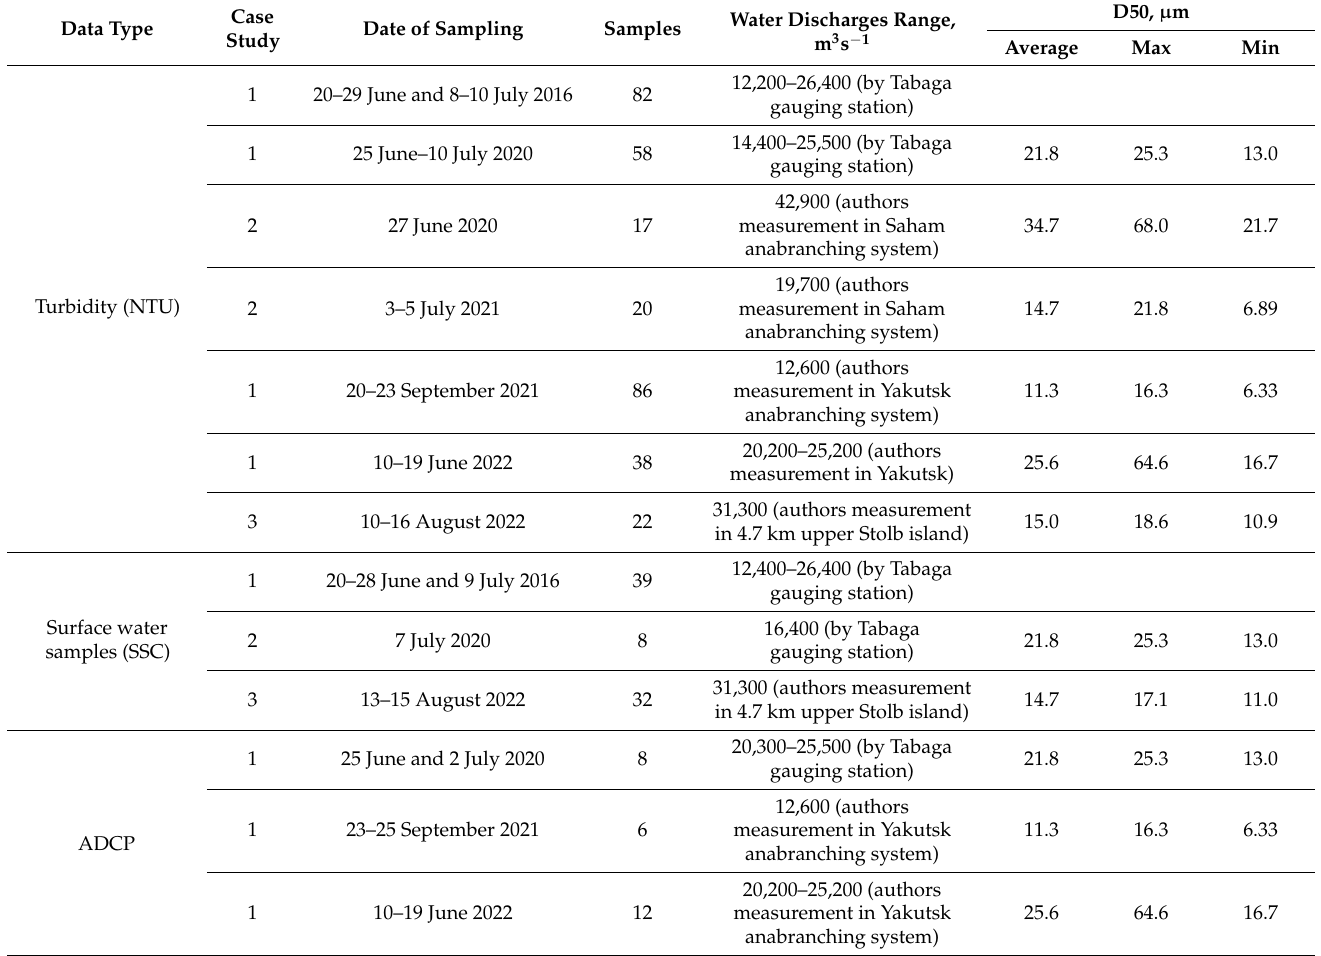
Table 1. Data characteristics used in empirical SSC models of the Lena